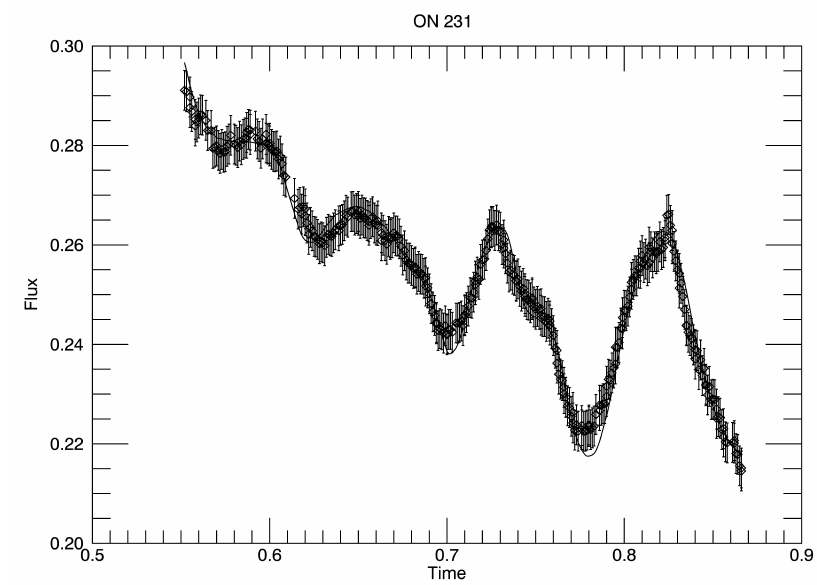
Figure 1. The micro-variability light curve of ON 231 taken over a single